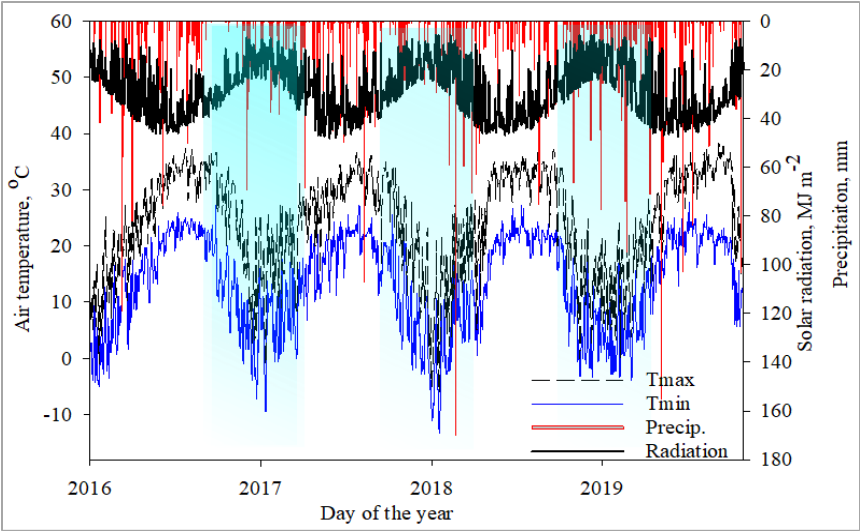
Figure 3. Daily maximum and minimum air temperatures, precipitation, and solar radiation from 1 January 2016 to 31 December 2019. Highlighted days are from 1 October to 31 March of each year in which TRCC grew.